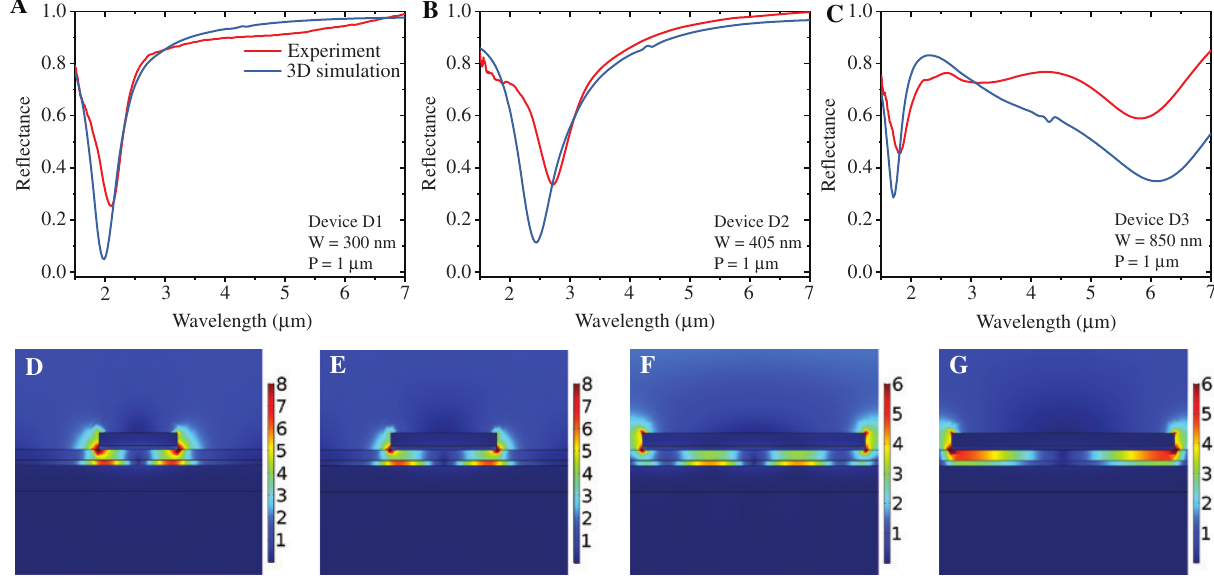
Figure 6: The simulations by 3D finite element method. (A–C) Comparison of the simulations and experimental FTIR reflectance measurements for devices D1, D2 and D3. (D) Electric field profile of device D1 calculated at λ = 2.0 μ m. (E) Electric field profile of device D2 calculated at λ = 2.45 μ m. (F, G) The electric field profiles of device D3 calculated at λ = 1.70 μ m and λ = 6.05 μ